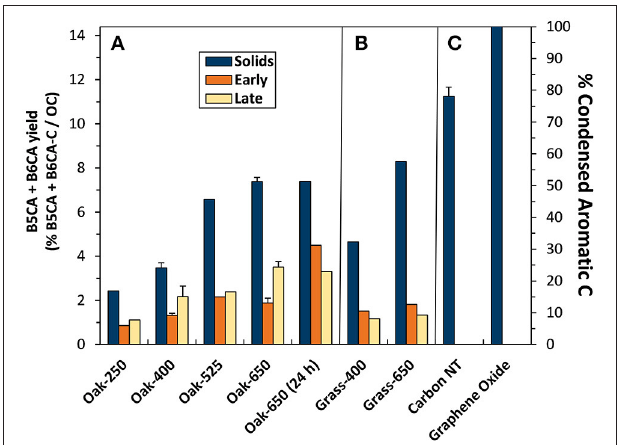
FIGURE 6 | Benzene penta- and hexa-carboxylated acid (B5CA + B6CA)-C yield (left axis) and calculated condensed aromatic C abundance (right axis) in biochar solids and “Early” and “Late” leachates of (A) oak char thermal series, (B) grass chars, and (C) reference